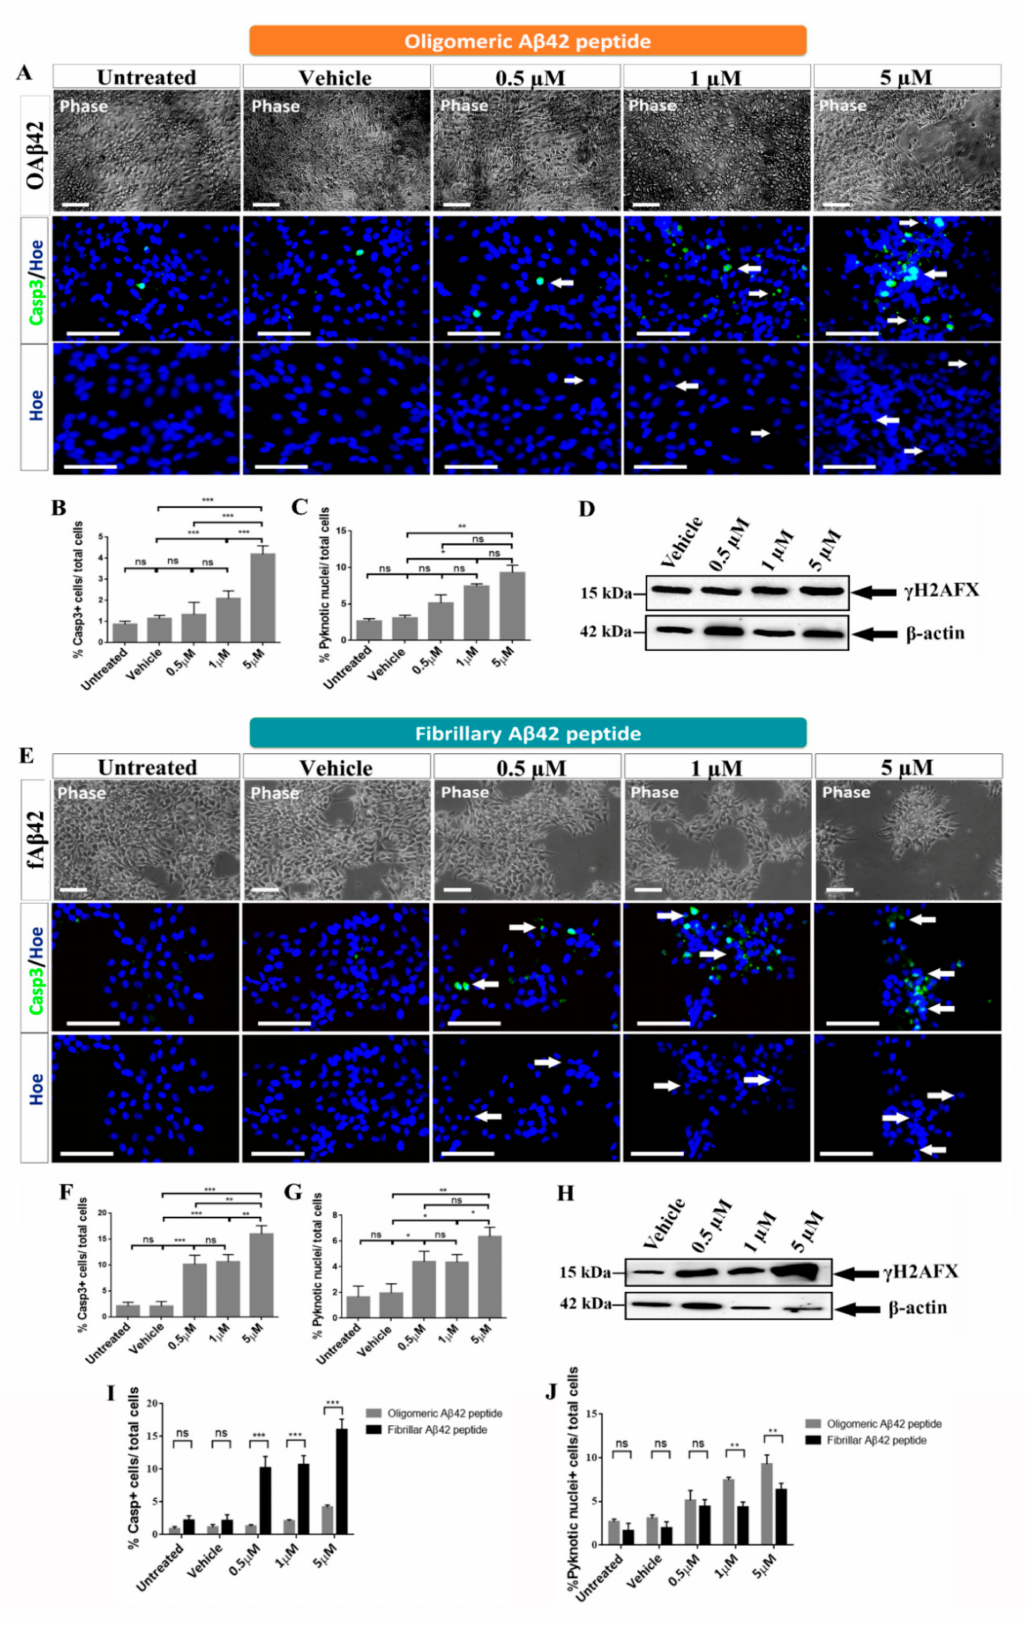
Figure 2. Oligomeric and fibrillary A β 42 increases cell death in differentiating hNS1 cells. ( A ) Representative phase-contrast images of hNS1 cultures treated with 0.5, 1, and 5 µ M of oligomeric A β 42 peptide (upper panels) and controls